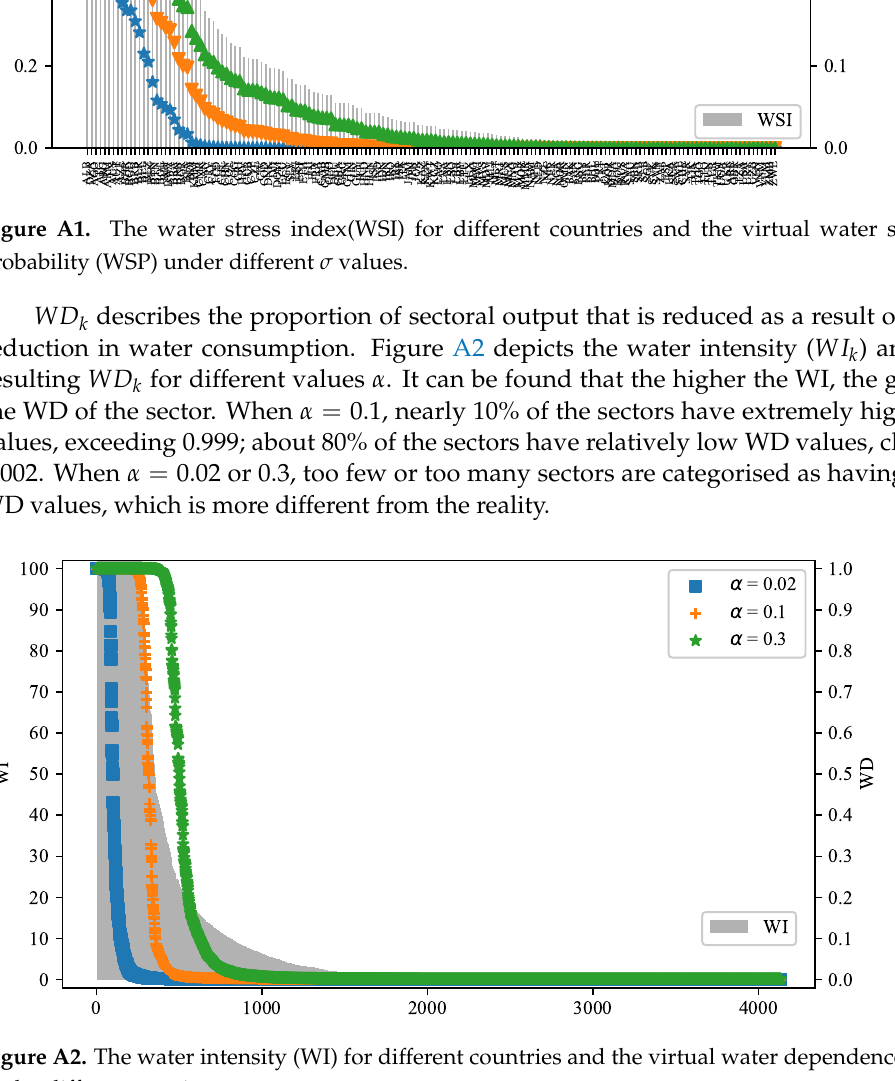
Figure A2. The water intensity(WI) for different countries and the virtual water dependence(WD) under different α